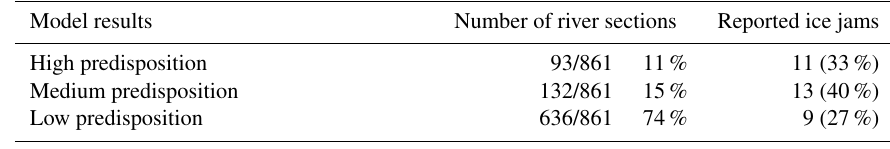
Table 5. Results and accuracy of the IJPI on the Saint-François River.